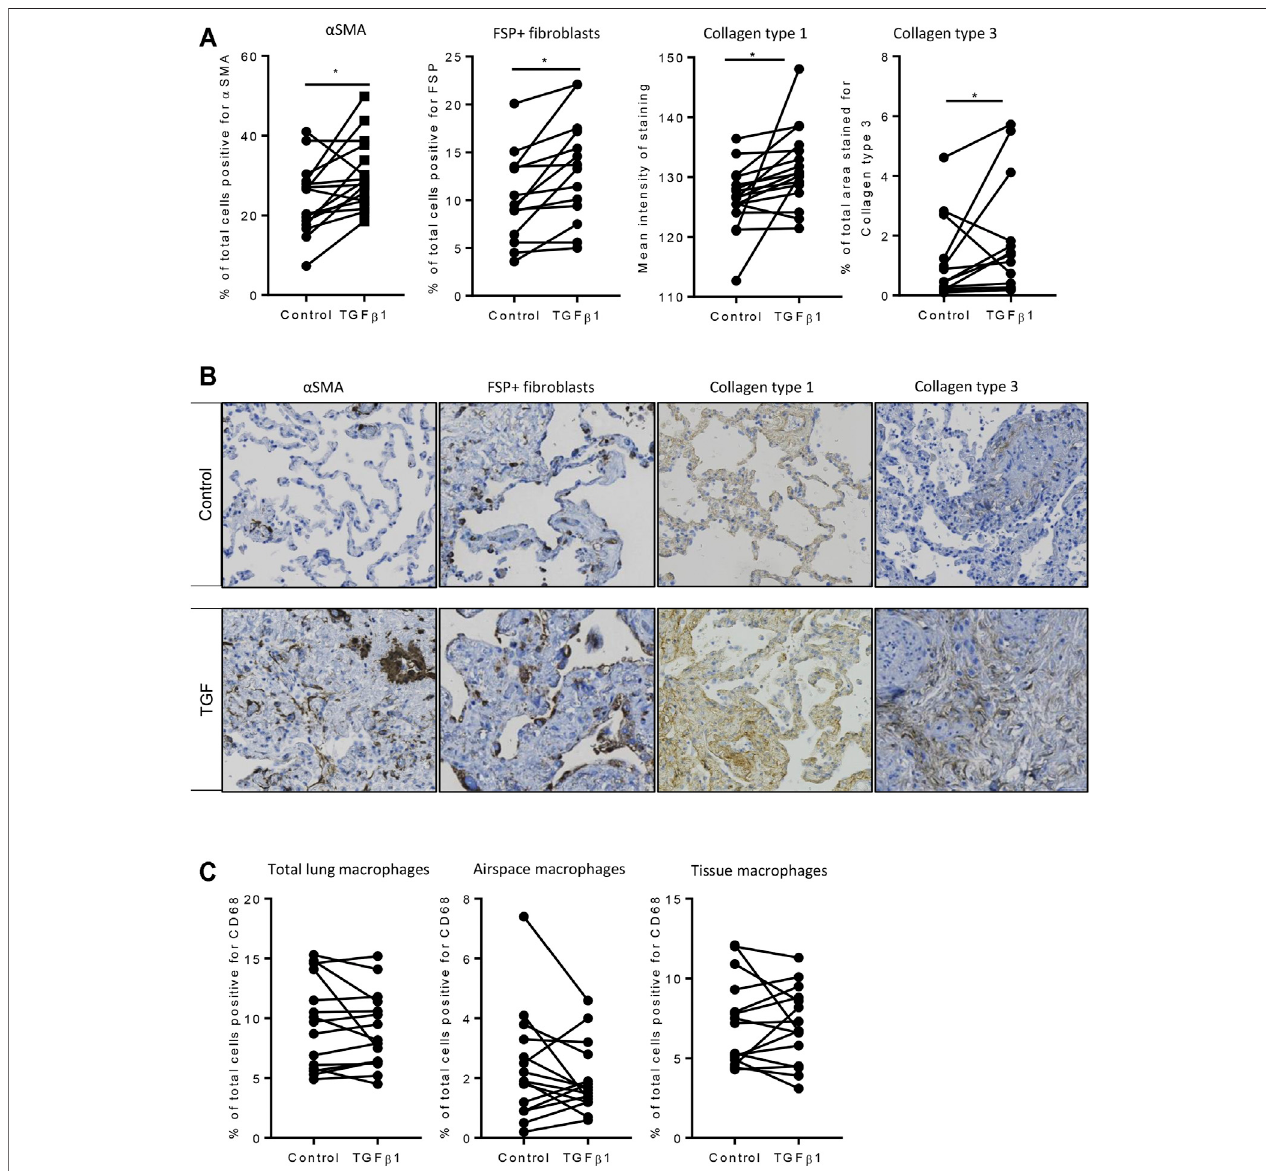
FIGURE 3 | ImmunohistochemicalanalysisofTGF β 1-stimulatedtissuecomparedtomatchedcontroltissue. (A ) Immunostainingwassigni fi cantlyincreased for α SMA ( p (cid:1) 0.0093, n (cid:1) 17),FSP+ fi broblast-likecells( p (cid:1) 0.0025, n (cid:1) 14),inTGF β 1(10 ng/ml)-stimulatedtissuecomparedcontroltissuefollowing7 daysof exvivo culture,collagen type1( p (cid:1) 0.0121, n (cid:1) 17),andcollagentype3( p (cid:1) 0.0302, n (cid:1) 15).* p < 0.05paired t test. (B) Representativeimmunohistochemicalstainingisdepictedforeachantibodyfor bothcontrolandTGF β 1-stimulatedtissuefollowing7 daysof exvivo culture.Relevantisotypecontrolswerenegative(imagesnotshown). (C) ThepercentageofCD68 + macrophages showed no signi fi cant changes in total, airspace or resident tissue macrophages numbers between control and TGF β 1-exposed lung tissue ( n (cid:1)